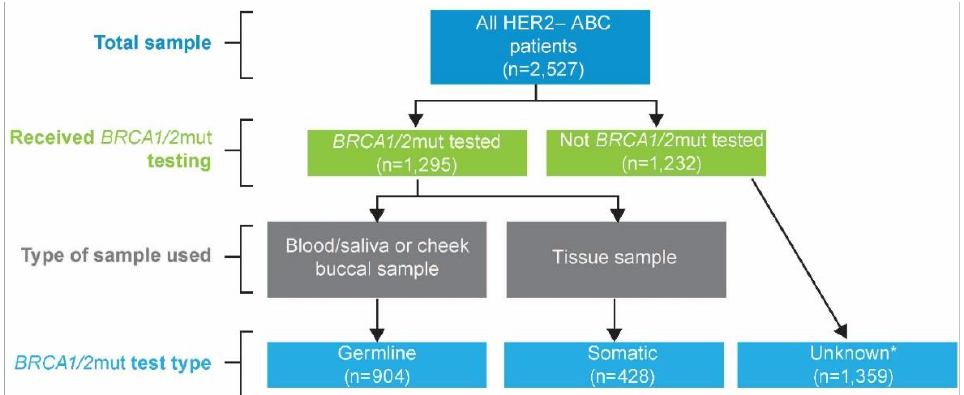
Figure 1. BRCA1/2 mutation status testing. ABC = advanced breast cancer; BRCA1/2 = breast cancer susceptibility gene 1 or 2; HER2 − = human epidermal growth factor receptor 2 negative. * Includes not tested; not known to have a germline BRCA1/2 mutation ( BRCA1/2 mut) test result; not known to have BRCA1/2 mut germline and somatic wildtype test results.